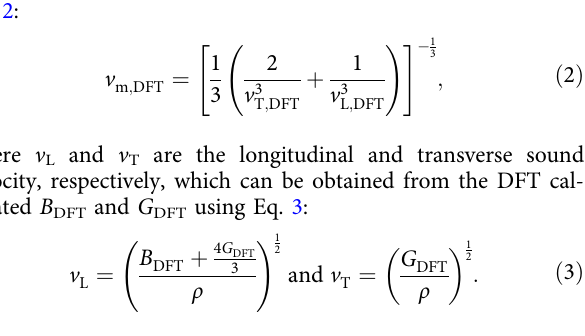
Periodic table of the (phosphor) elements